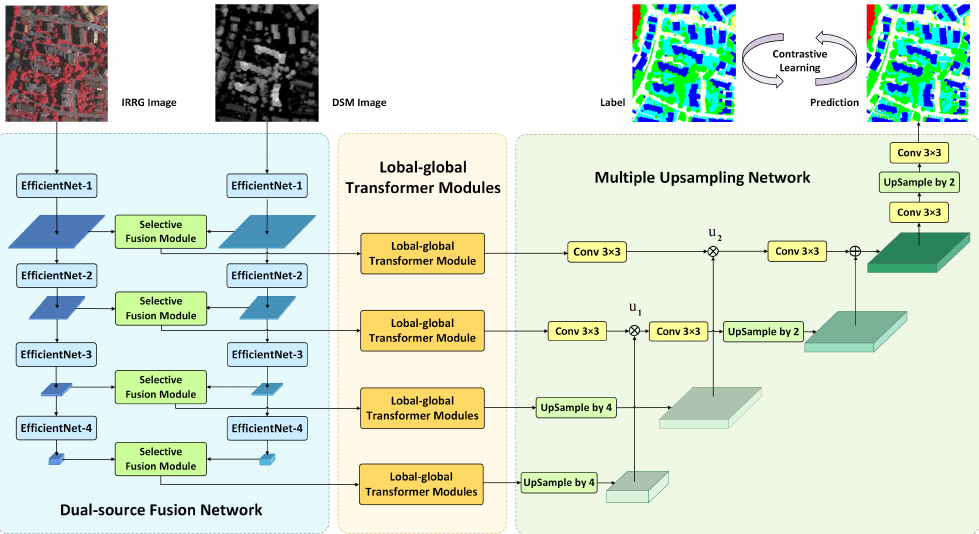
Figure 2. The overview of the Local–global Framework